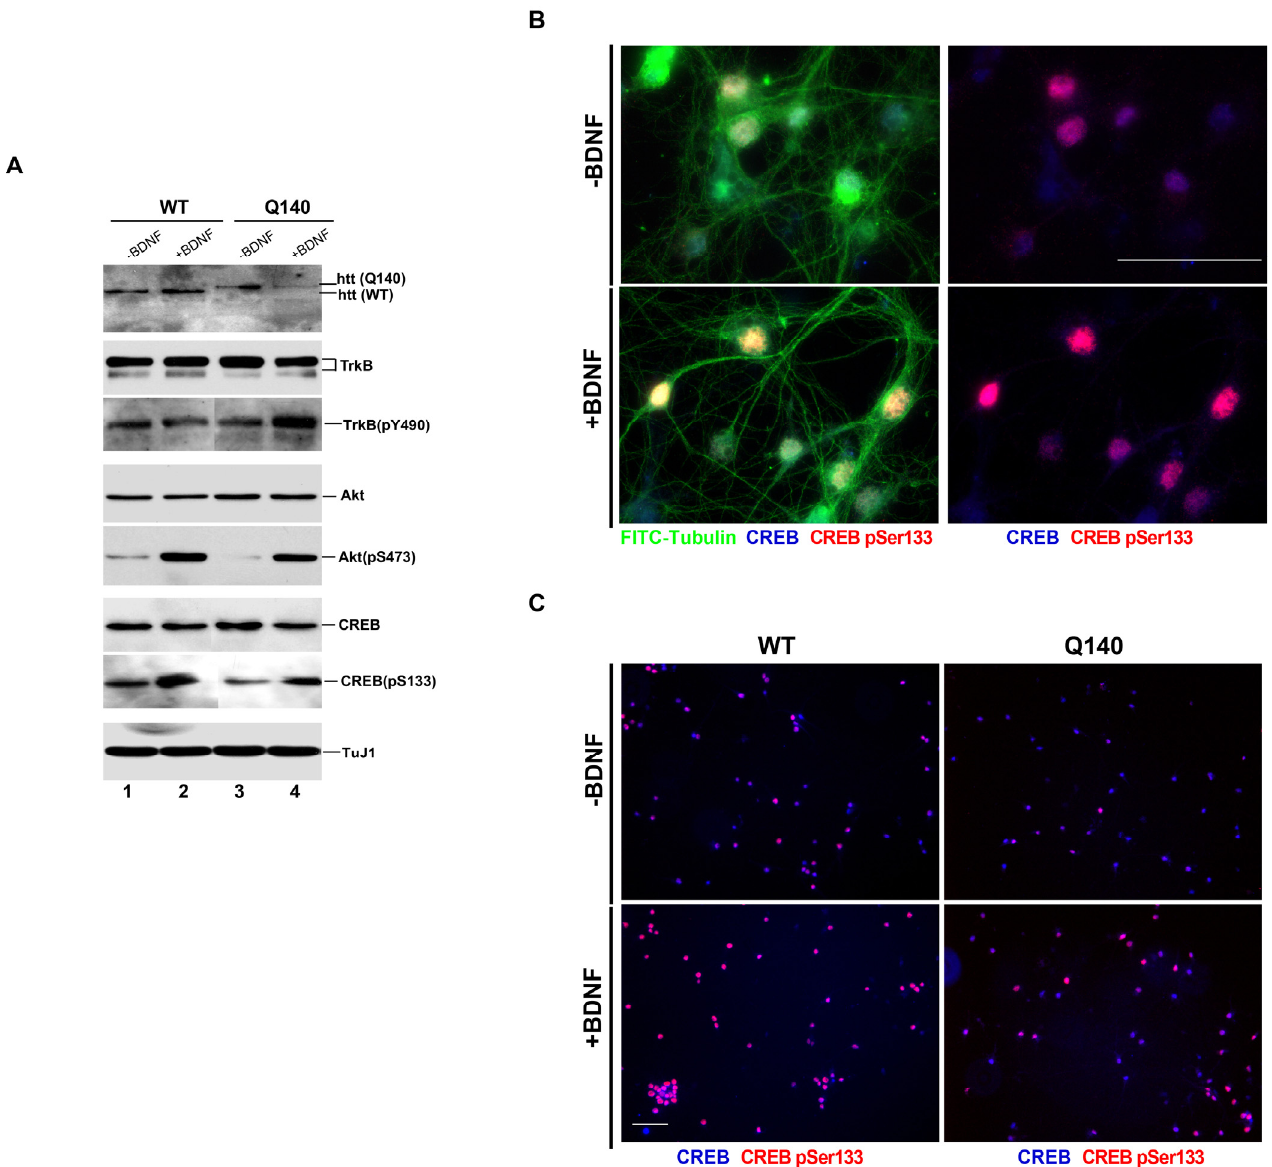
Figure 1. BDNF effect on the BDNF-TrkB signalling pathway in Q140 striatal neurons. ( A ). Representative immunoblots of TuJ1, TrkB, TrkB (pY490), Akt, pAkt (pS473), CREB and pCREB (pS133), and in WT and Q140 cells with and without BDNF (25 ng/mL) for 30 min. We detect reduced levels of pAkt (p8473) and pCREB (pS133) in Q140 (lane 3 compared to lane 1 in WT. Repeated in triplicates. ( B ). Striatal neuron staining with FITC-tubulin CREB and pCREB (pSer133) confirms that the activation of CREB into pCREB in WT occurs with BDNF after 30 min. ( C ). Staining with CREB and pCREB (pSer133) shows alterations of pCREB in WT and Q140 after 30 min inductions, with or without BDNF (25 ng/mL). Repeated in triplicates. Scale bar is 100 µm.